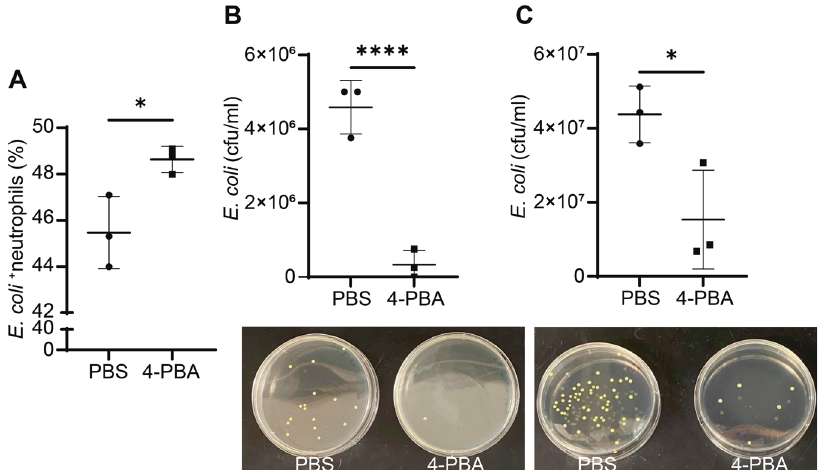
Fig. 3 Resolving neutrophils trained by 4-PBA exhibit enhanced phagocytosis and bacterial-killing activities. A Flow analyses of neutrophil phagocytosis of GFP-labeled E. coli . WT neutrophils programmed with PBS or 4-PBA (1 mM; 24 hours) were subsequently co- incubated with GFP-labeled E. coli for 20 min. Following washing, neutrophils were subjected to fl ow analyses, and the percentages of GFP- E. coli containing neutrophils were counted and plotted ( n = 3). B Analyses of bacterial killing through plating of viable E. coli harvested from lysed neutrophils. WT neutrophils programmed with PBS or 4-PBA (1 mM; 24 hours) were subsequently co-incubated with GFP-labeled E. coli for 30 min. Following washing, neutrophils were lysed and plated on bacterial culture plates. The numbers of viable E. coli were counted (bottom panel) and the CFU (colony-forming units) were plotted (upper panel) ( n = 3). The representative image of viable intracellular E. coli from each group was shown. C Analyses of bacterial killing through plating of viable E. coli collected from culture supernatants. WT neutrophils programmed with PBS or 4-PBA (1 mM; 24 hours) were subsequently co-incubated with GFP-labeled E. coli for 30 min. Culture supernatants containing extracellular viable bacteria were plated (bottom panels showing representative culture images) and counted (upper panel) ( n = 3). Data were plotted as mean ± SD. * P < 0.05 using two-sided Student ’ s t test. ( A , B , and C